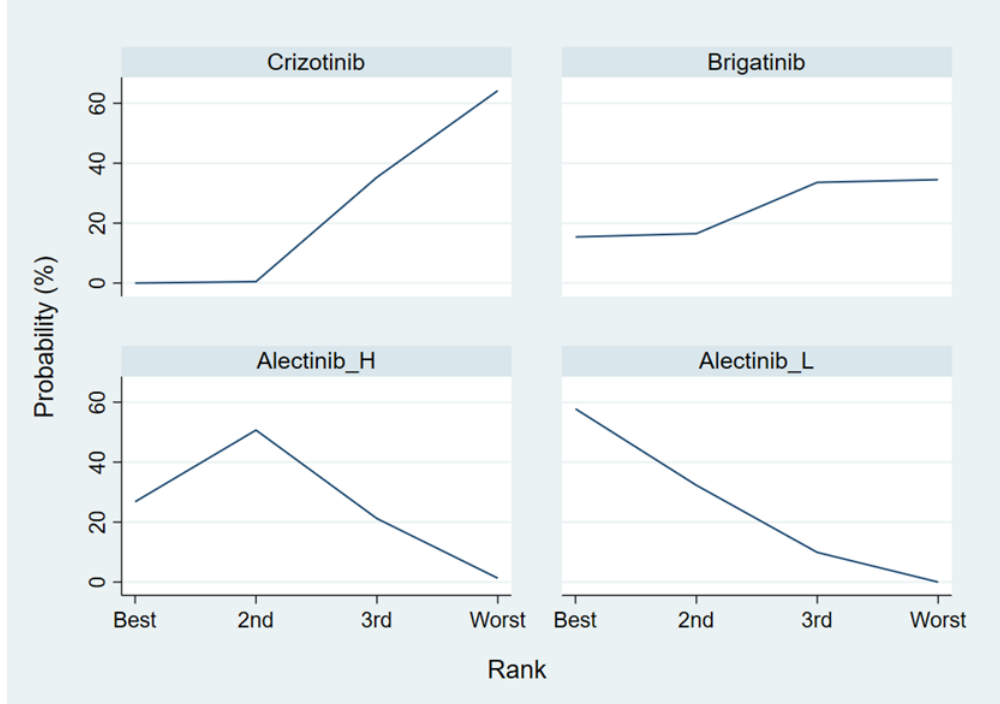
Figure A6. Probability of being the best treatment with regard to progression free survival (PFS).